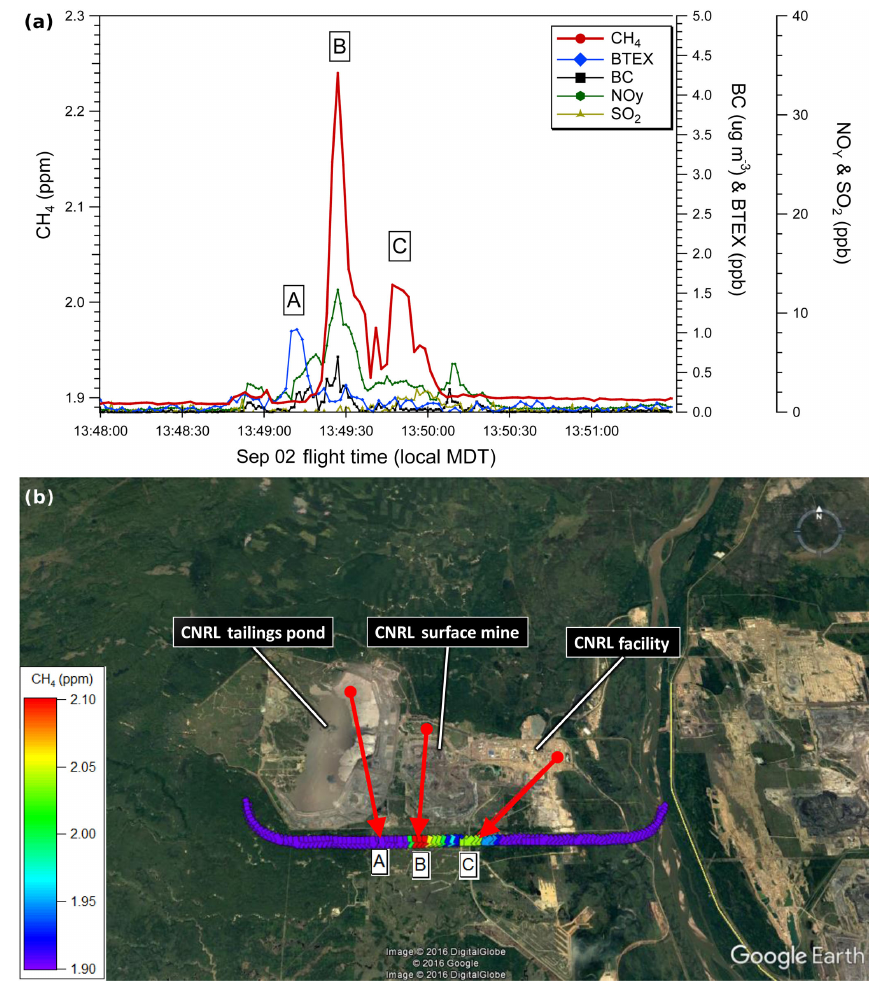
Figure 3. (a) Aircraft measurements of CH 4 (red), BTEX (blue) and r BC (black) from a single transect ∼ 150m a.g.l. downwind of CNRL. Plume A (CNRL tailings pond), Plume B (CNRL mine) and Plume C CNRL facility. (b) CH 4 mixing ratios along the 150m a.g.l. transect for the above time series. Each data point is color coded for the CH 4 mixing ratio and instantaneous wind vector measured on the aircraft at that location. Red arrows show back trajectories based on the linear extrapolation of measured wind speed and